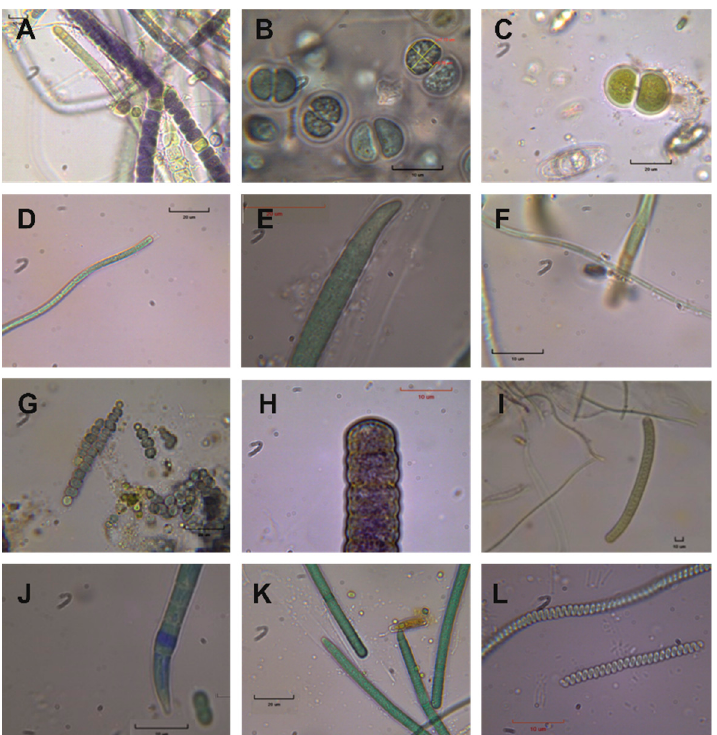
Figure 7. Cyanobacterial microflora under an optical microscope. ( A ) 9- Brasilonema cf. angustatum (Scale bar: 50 μ m), ( B ) Chroococcus cf. mediocris (Scale bar: 50 μ m), ( C ) Chroococcus subnudus (Scale bar: 20 μ m), ( D ) Jaaginema thermale (Scale bar: 20 μ m), ( E ) Kamptonema formosum (Scale bar: 20 μ m), ( F ) Leptolyngbya ercegovicii (Scale bar: 10 μ m), ( G ) Nostoc punctiforme (Scale bar: 20 μ m), ( H ) Oscillatoria crassa (Scale bar: 10 μ m), ( I ) Oscillatoria subbrevis (Scale bar: 40 μ m), ( J ) Oxynema acuminatum (Scale bar: 50 μ m), ( K ) Phormidium cf. abronema (Scale bar: 20 μ m), ( L ) Spirulina subtilissima (Scale bar: 10 μ m).